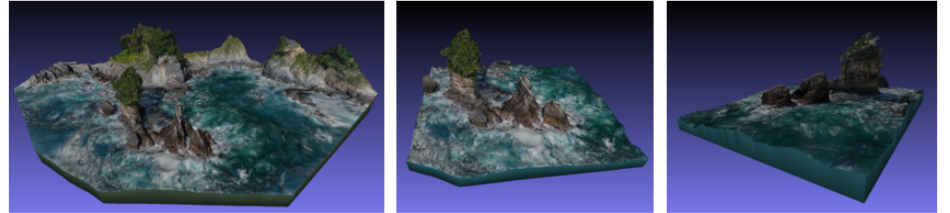
Figure 14. 3D printer models (overview, clipped front, and clipped back).